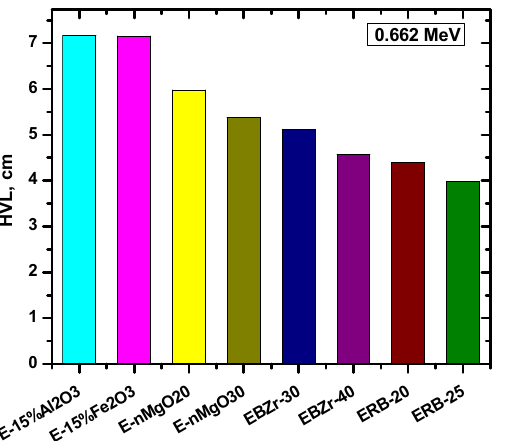
Figure 10. The half value layer for the prepared composites at 0.662 MeV in comparison with other